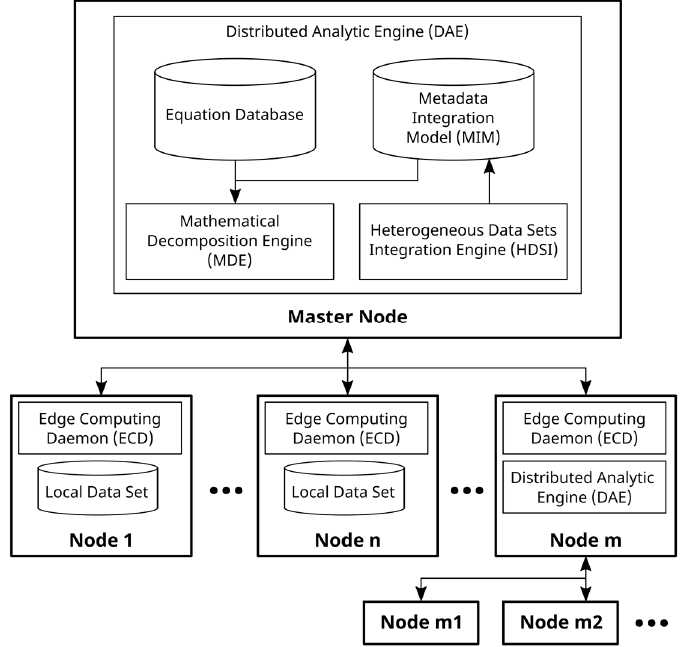
Figure 1. Overview of the general system architecture.